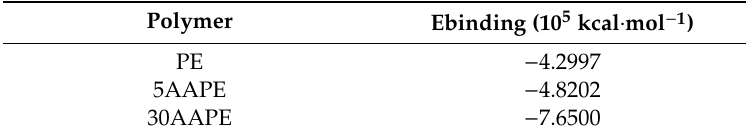
Table 3. Binding energy of the polymers to the zirconia substrate.